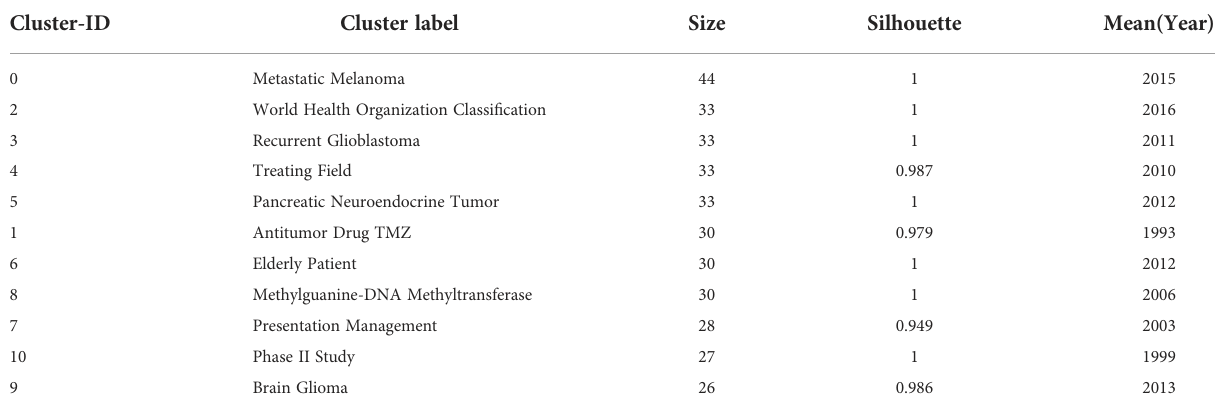
TABLE 4 The detailed information of the 11 clusters in